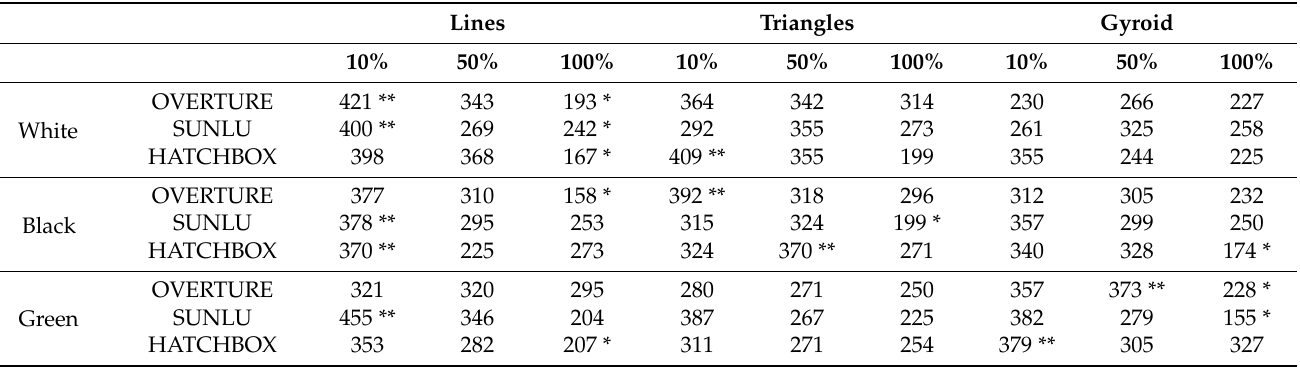
Table 5. Filament scoring across all nine printer conditions, with varying infill density and infill pattern, produces S Combined scores based upon the contributions from dimensional accuracy and mechanical properties (* optimal parameter set identified for a given filament; ** worst-case parameter set identified for a given